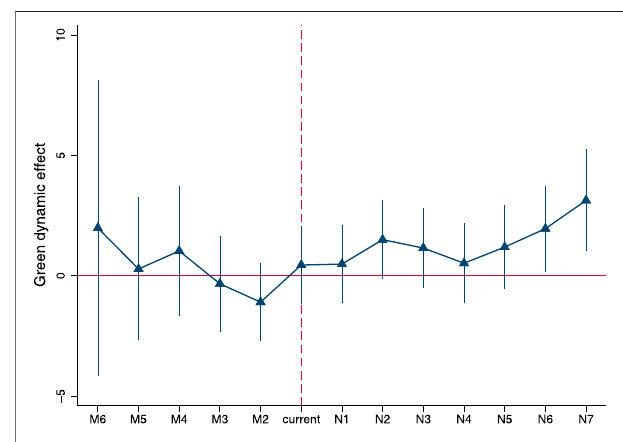
FIGURE 4 | Parallel trend test result of the proportion of clean power generation.